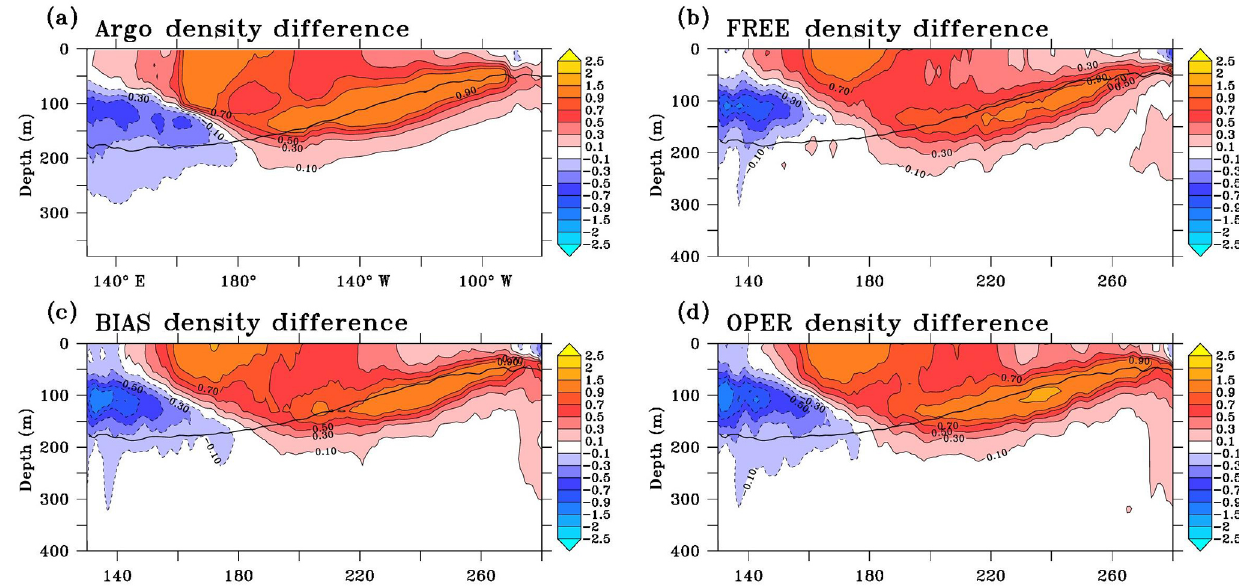
Figure 15. Density difference (October–December 2008 minus October–December 2009) in the equatorial Pacific (2 ◦ S–2 ◦ N) above 400m of depth (a–d) from the SCRIPPS Argo product (a) and the three 1 / 12 ◦ PSY4 FREE, BIAS and OPER simulations (b–d) . The black line indicates the 2007–2015 Argo mean position of the pycnocline depth (isopycn 1025kgm − 3